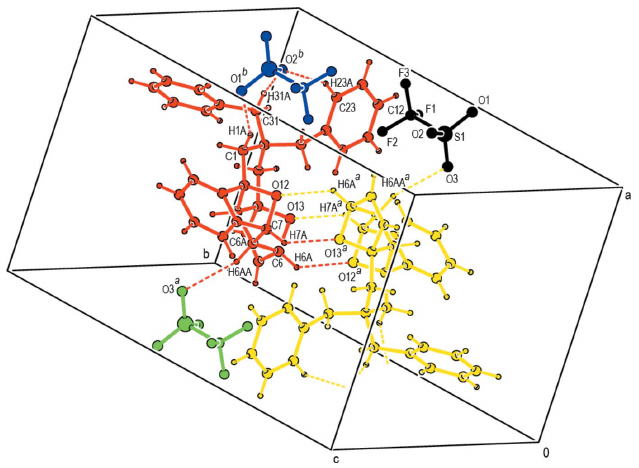
Figure 3 A general view of the intermolecular C—H (cid:2)(cid:2)(cid:2) O hydrogen bonds (depicted by dashed lines) in the unit cell of the title salt 1 . [Symmetry codes: ( a ) 1 (cid:3) x , 1 (cid:3) y , 1 (cid:3) z ; ( b ) 2 (cid:3) x , 1 (cid:3) y , 1 (cid:3) z ].